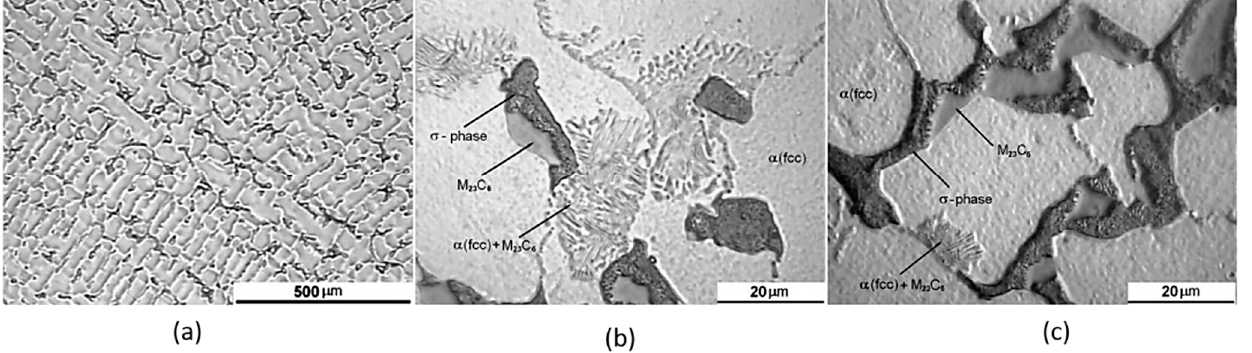
Figure 6. ( a ) Dendritic microstructure of a cast cobalt alloy, ( b ) σ phase and carbide precipitation for an upper cast section, and ( c ) thicker and continuous carbide chain presenting different cooling rates at lower cast sections [157].